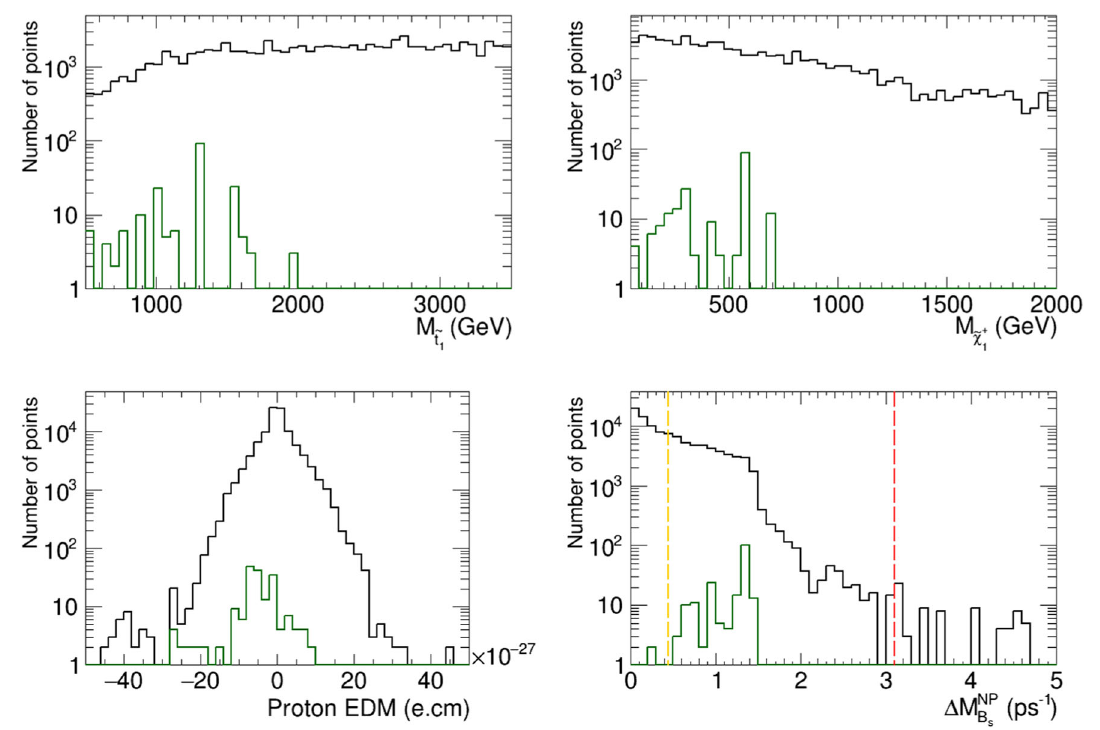
Fig. 10 Distributions of the lighter stop mass (upper left), lighter chargino mass (upper right), proton EDM (lower left) and (cid:3) M NP (lower right), showing the effects of a possible Belle-II measure- ment of A CP ( b → s γ) as well as the LHC constraints on sparticle masses and the EDM constraints. Black histograms: all points pass- ing the LHC mass and flavour constraints and the current EDM limits;